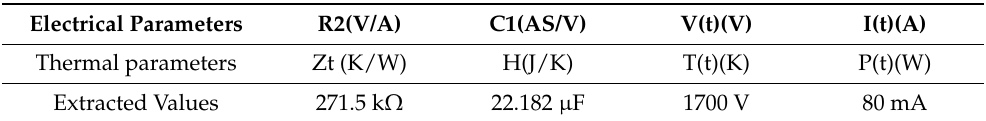
Figure 4. The flow chart of building the electro-optical-thermal Modelling. Table 1. Correspondence between the characteristics of the electrothermal model and the electrical equivalent parameters.